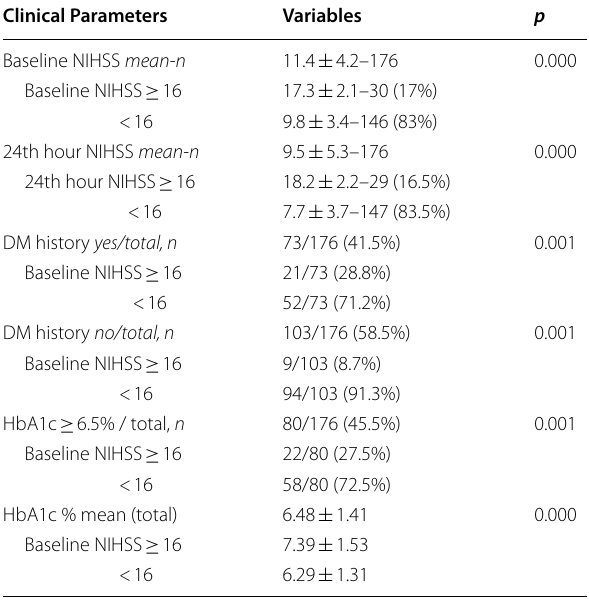
Table 2 Relationship of clinical severity with DM and HbA1c